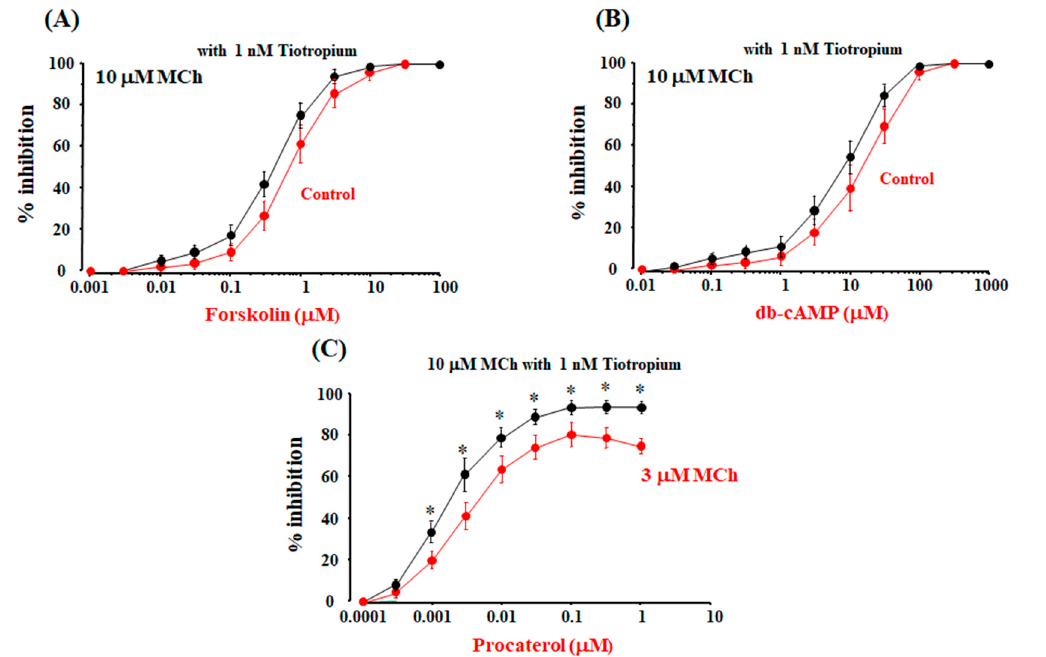
Figure 6. The synergistic effect is not due to bypassing β 2 -adrenergic receptors and blocking muscarinic receptors. Concentration-inhibition curves for forskolin ( A ) and db-cAMP ( B ) in the absence and presence of tiotropinm (1 nM). ( C ) Concentration-inhibition curves for procaterol against MCh (3 μ M)-induced contraction. The curve for procaterol against MCh (10 μ M) with tiotropium (1 nM) is superimposed (ref. Figure 5A). *: p < 0.05.